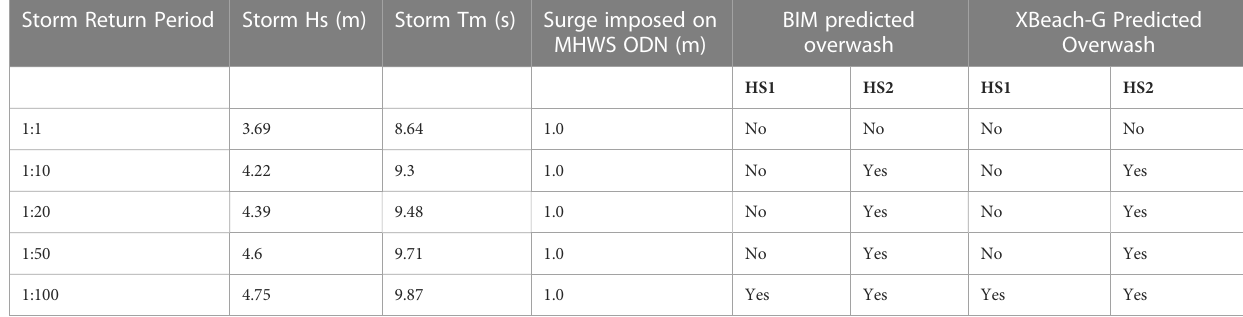
TABLE 2 Conditions used for BIM and a comparison of XBeach-G predictions of overwashing with BIM. Storm Return Period Storm Hs (m) Storm Tm